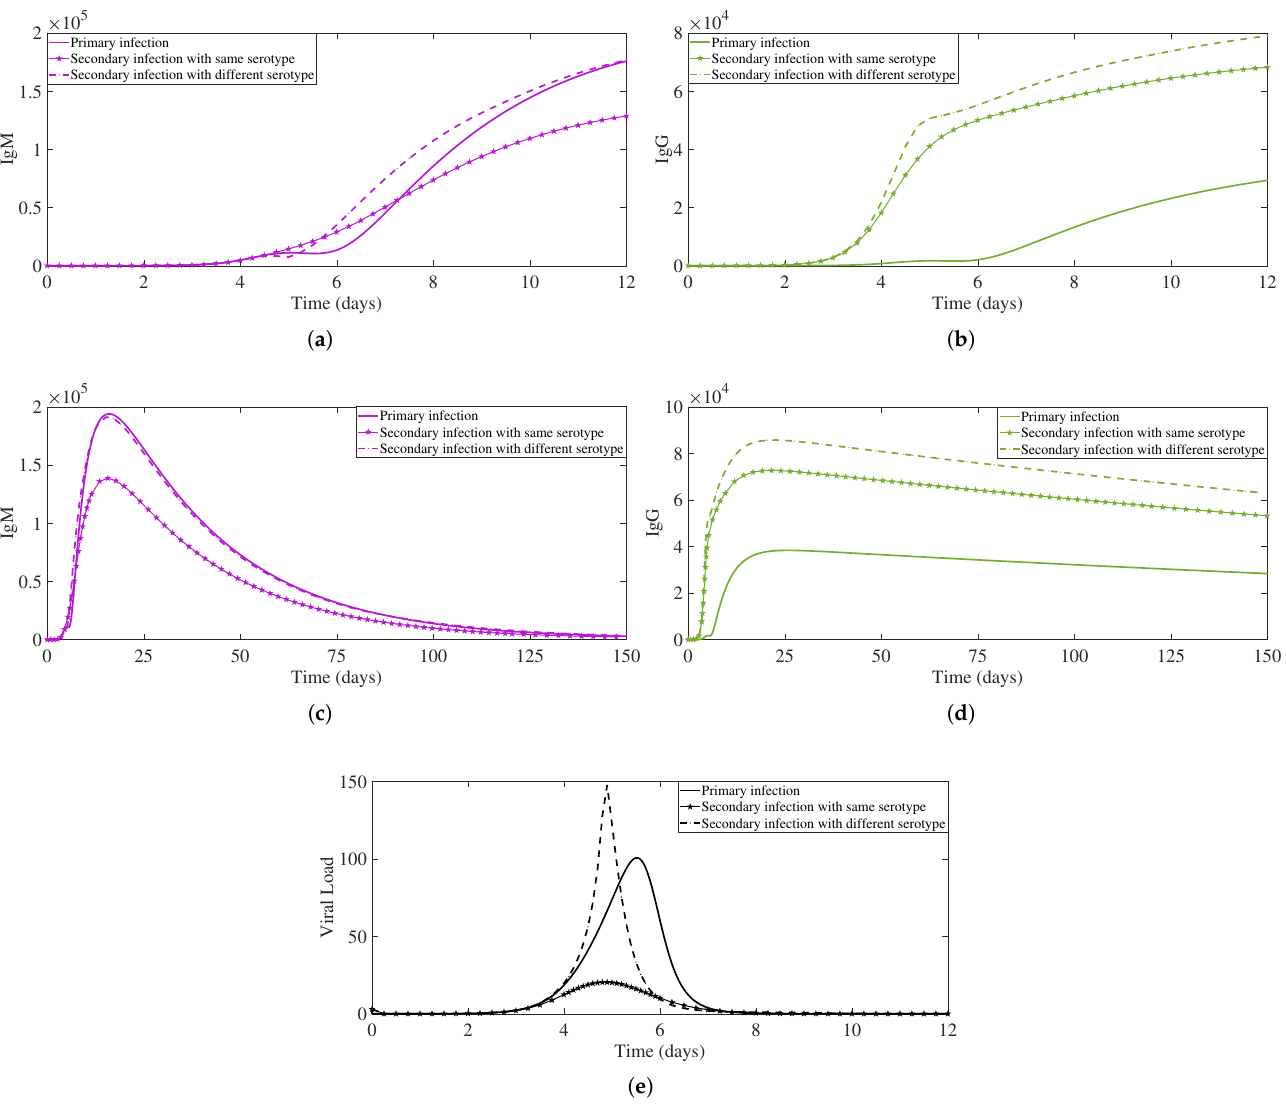
Figure 10. Antibody responses and free viral load comparison. For a primary dengue infection (full line), secondary infection with a homologous dengue serotype (line with pentagram marker), and secondary infection with heterologous dengue serotype (dashed line), we show the dynamics for IgM antibody type (in violet) and IgG antibody type (in green). In ( a , b ), we plot the antibodies dynamics over a 12-day period while in ( c , d ) over a 150-day period. Free viral load dynamics are shown in ( e